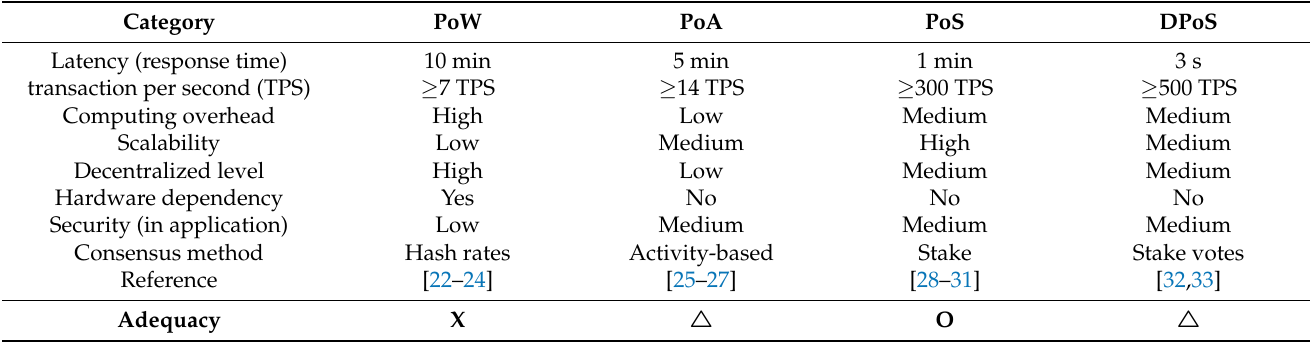
Table 1. Quantitative indicator analysis of consensus algorithms